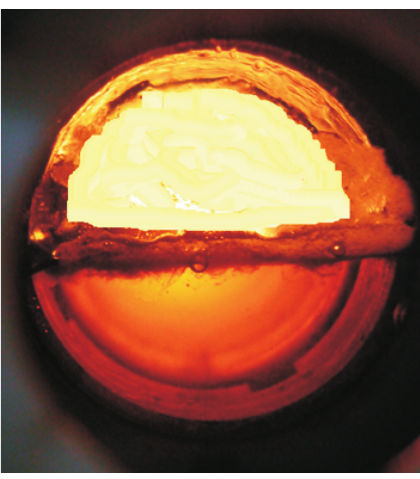
Figure 1: Kinetic observation of hydrate formation process. Figure 2: Process of a bubble transforming into